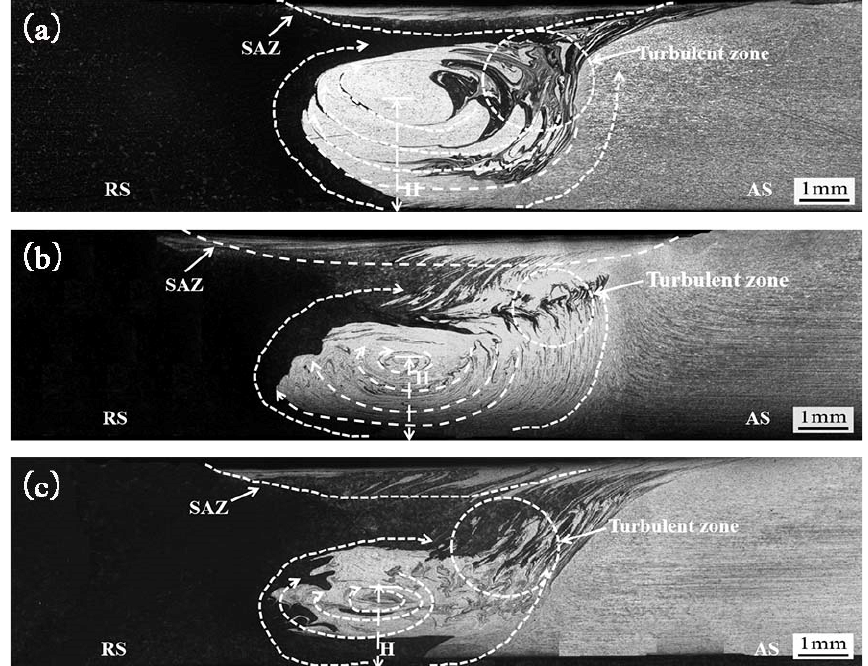
Figure 6. Macroscopic characteristics of weld cross-section flow obtained using three tool pins. ( a ) tool pin A; ( b ) tool pin B; ( c ) tool pin C.